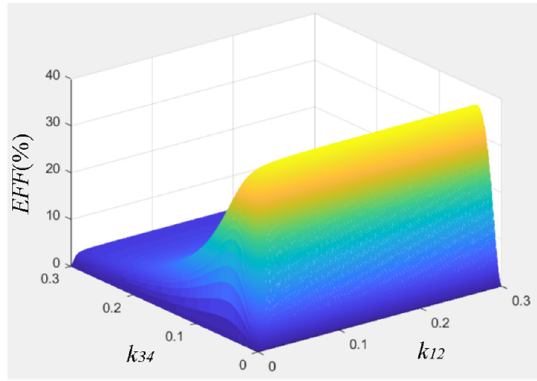
Figure 2. Transfer efficiency of the overall system.